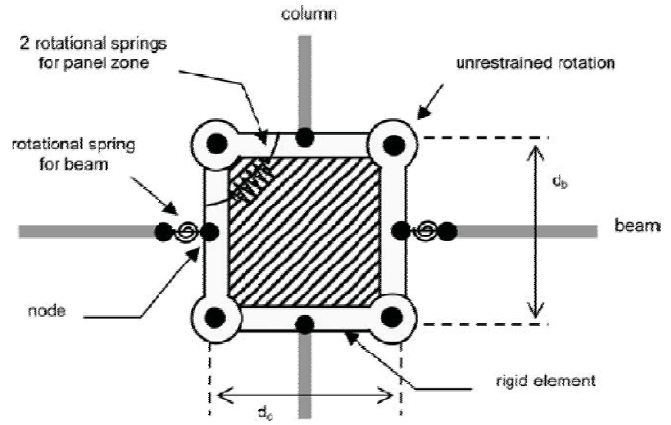
Figure 10. Connection source model using an eight-node model.